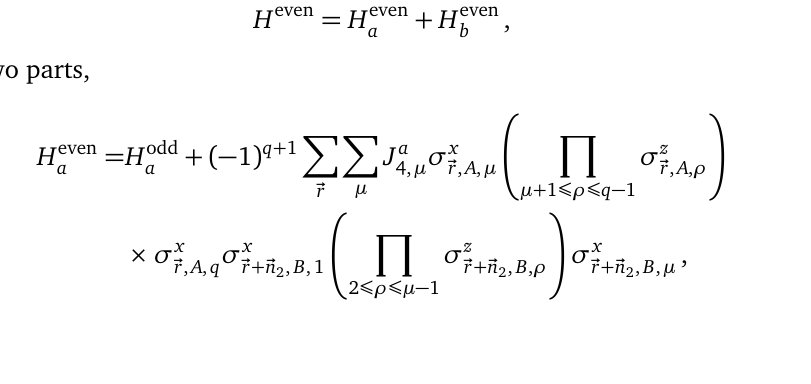
Figure 5: (a) A 2D lattice where the Hamiltonian (13) is defined. A bond in brown is added to connect the sites ⃗ r , A , q and ⃗ r + ⃗ n 2 D lattice. (b) and (c) denotes the J a respectively. Blue stars represent the product of σ z ’s on corresponding abbreviated